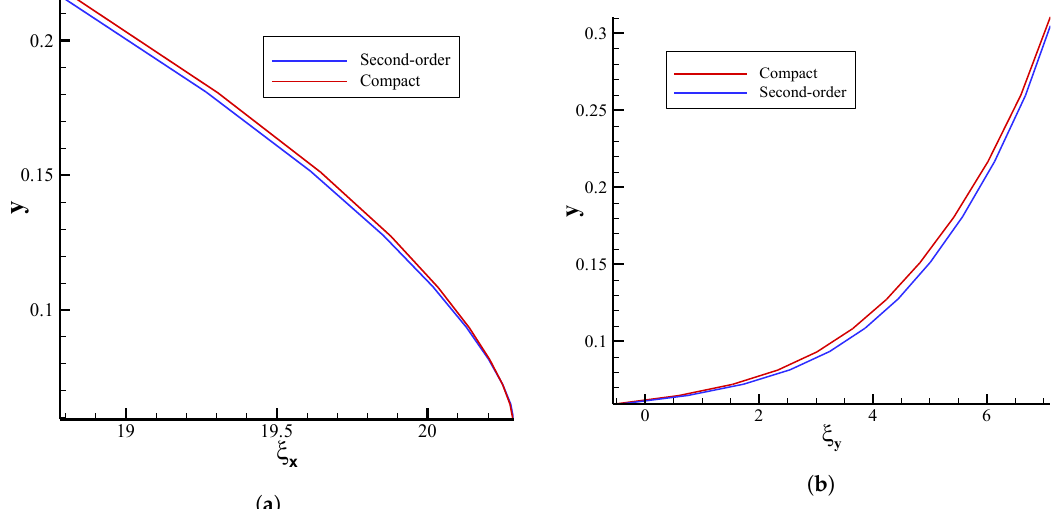
Figure 9. Comparison of the computational metrics ( a ) ξ x and ( b ) ξ y at x = 0.5 for the C-type